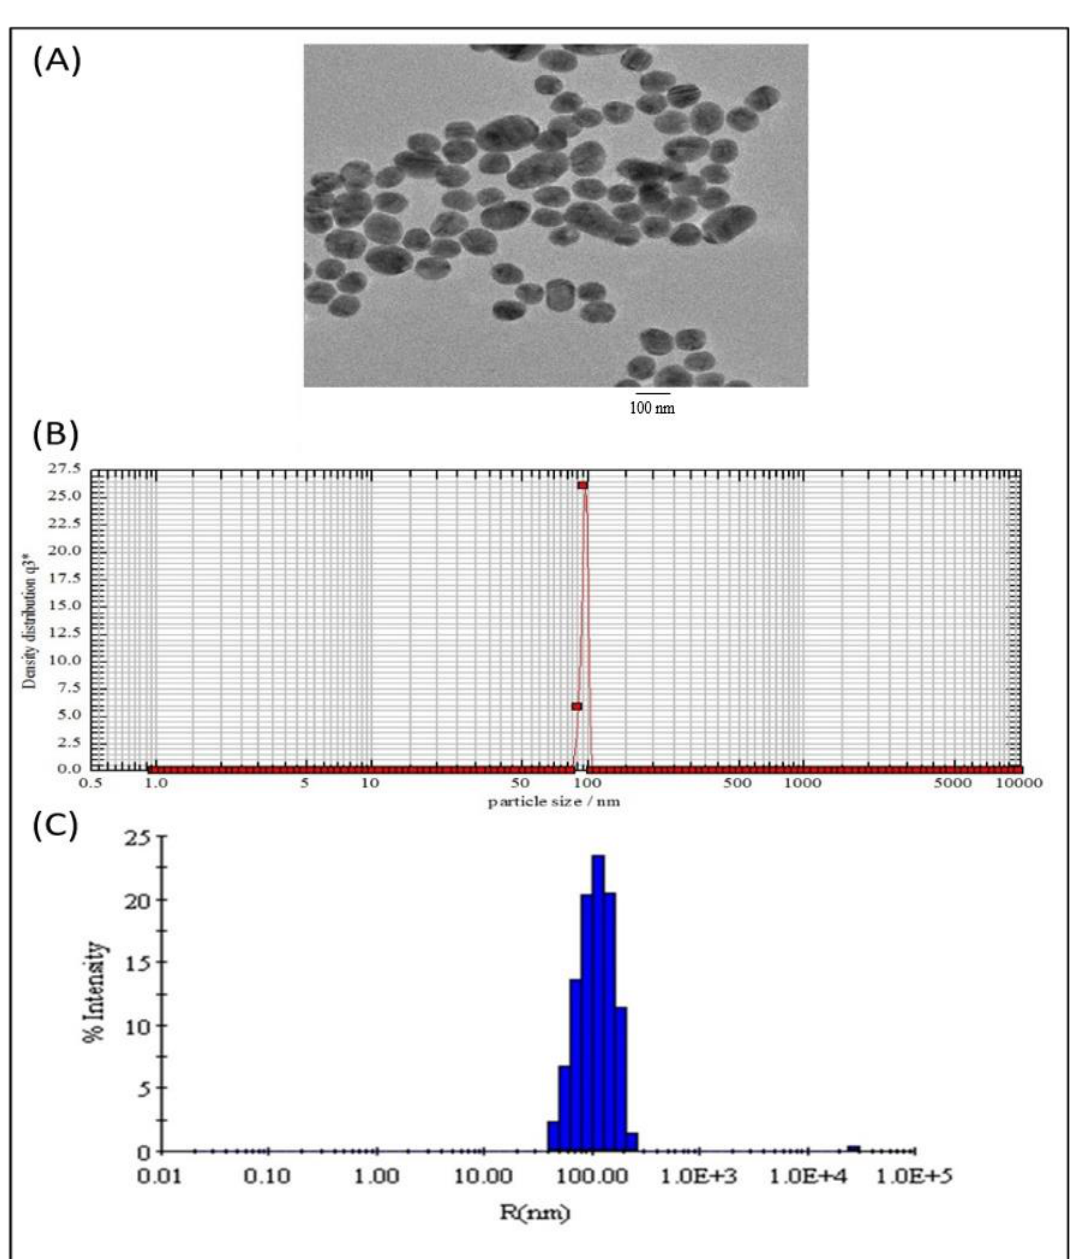
Figure 1. Size distribution and morphology of subtilosome-based siRNA nanoparticles. ( A ) Trans- mission electron microscopy showed that the siRNA-subtilosomes were spherical in shape, with an average size of 95 ± 10 nm. ( B ) Particle-size distribution of siRNA-subtilosomes assessed by photon-correlation spectroscopy. ( C ) The Z-average diameter of the siRNA-subtilosomes determined by dynamic light scattering measurements was 105 ± 0.7